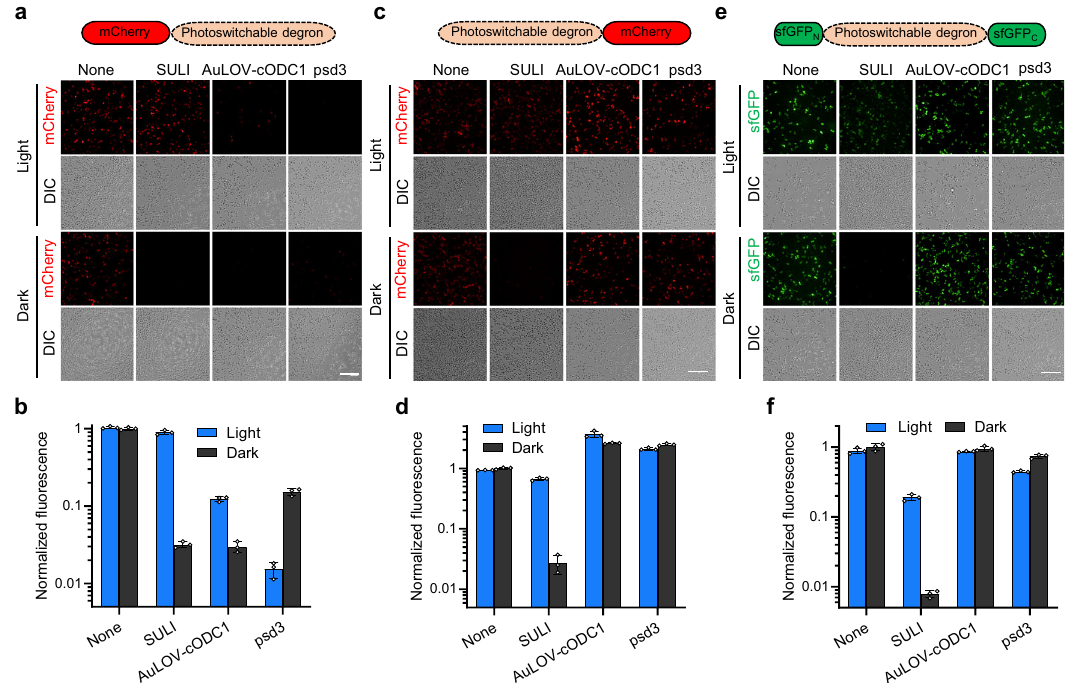
Fig. 2 | Tolerance of SULI to fusion at different positions of the target protein. The photoswitchable degrons SULI, AuLOV-cODC1, and psd3 were fused to the C- a , b orN-terminal( c , d )ortheinnerregion( e , f )ofthe reporterprotein.Yeast cells expressing these fusion proteins were cultured upon blue light illumination or underdarkconditionsfor15hbeforethe fl uorescencewasimagedby fl uorescence